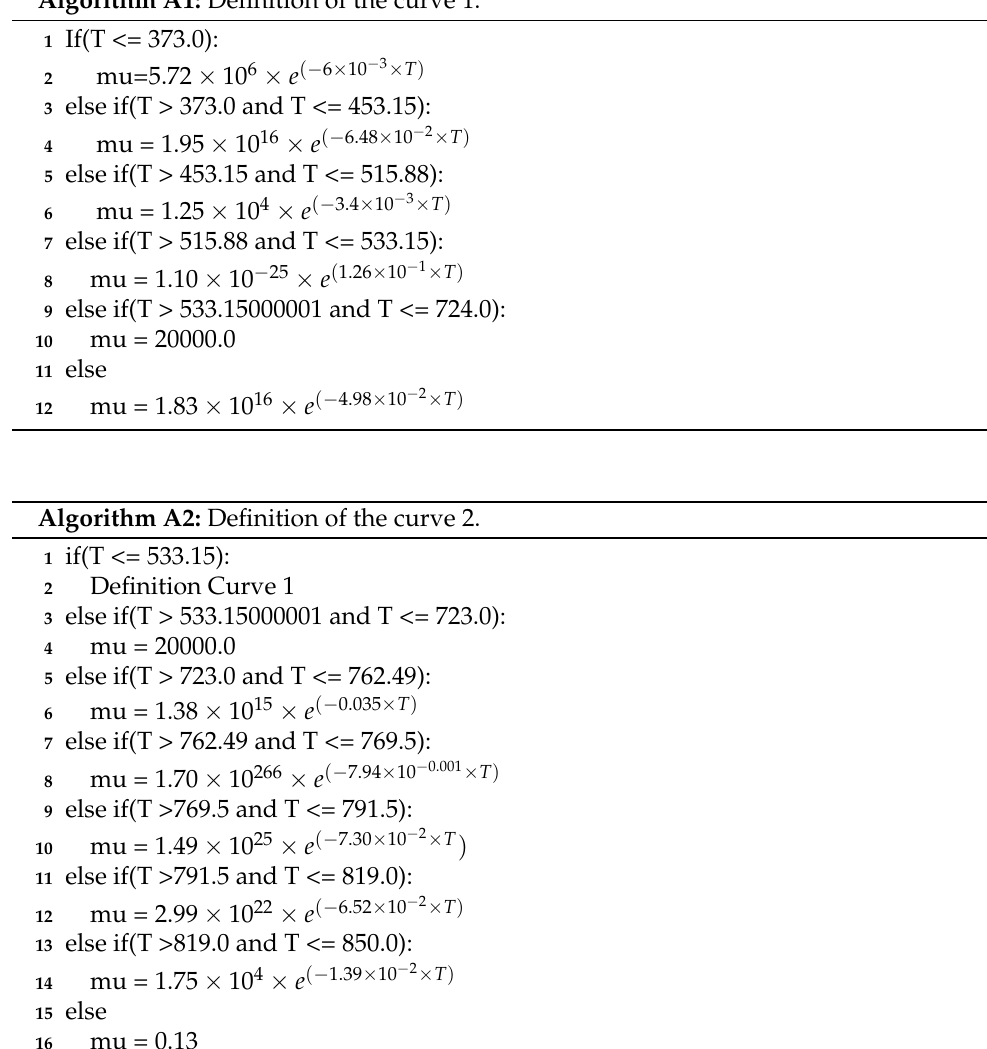
Algorithm A1: Definition of the curve 1.